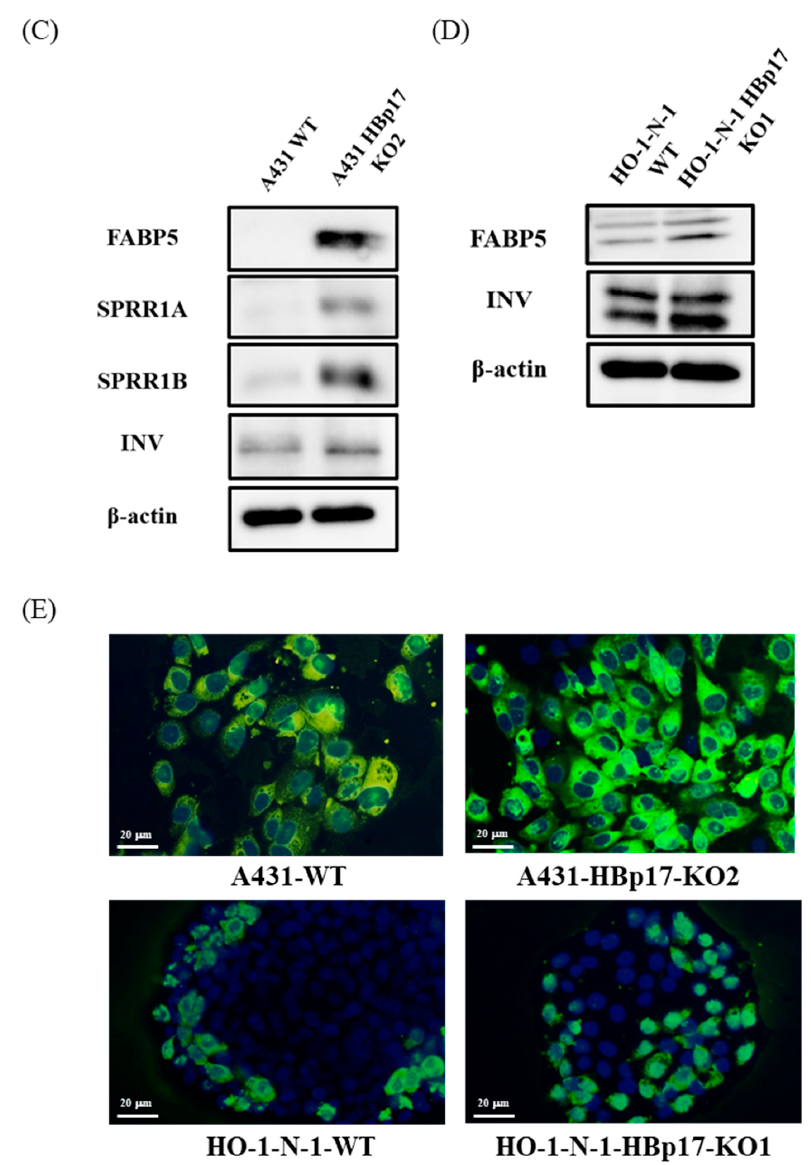
Figure 7. Knocking out HBp17 induces the expression of cornified envelope-related proteins. ( A ) Upregulation of FABP5, SPRR-A, SPRR-B, IVL, LOR, and FLG mRNAs in A431-HBp17-KO2 cells was evaluated by qRT-PCR. ( B ) In HO-1-N-1-HBp17-KO1, the expression of FABP5, IVL, and FLG mRNAs was elevated. GAPDH levels were used as an internal control. Experiments were performed in triplicate, with the data presented as means ± SD. * p < 0.05. Increased cornified envelope-related protein expression in A431-HBp17-KO2 ( C ) and HO-1-N-1- HBp17-KO1 cells (D) was evaluated by Western blot. ( E ) Immunofluorescence staining for IVL (green) in A431-HBp17-KO2 and HO-1-N-1-HBp17-KO1, A431-WT, and HO-1-N-1-WT cells. Cell nuclei were stained with DAPI (blue). Abbreviations: fatty acid-binding protein 5 (FABP5), small proline-rich protein 1A (SPRR1A), small proline-rich protein 1B (SPRR1B), Involucrin (IVL), Loricrin (LOR), Filaggrin (FLG).